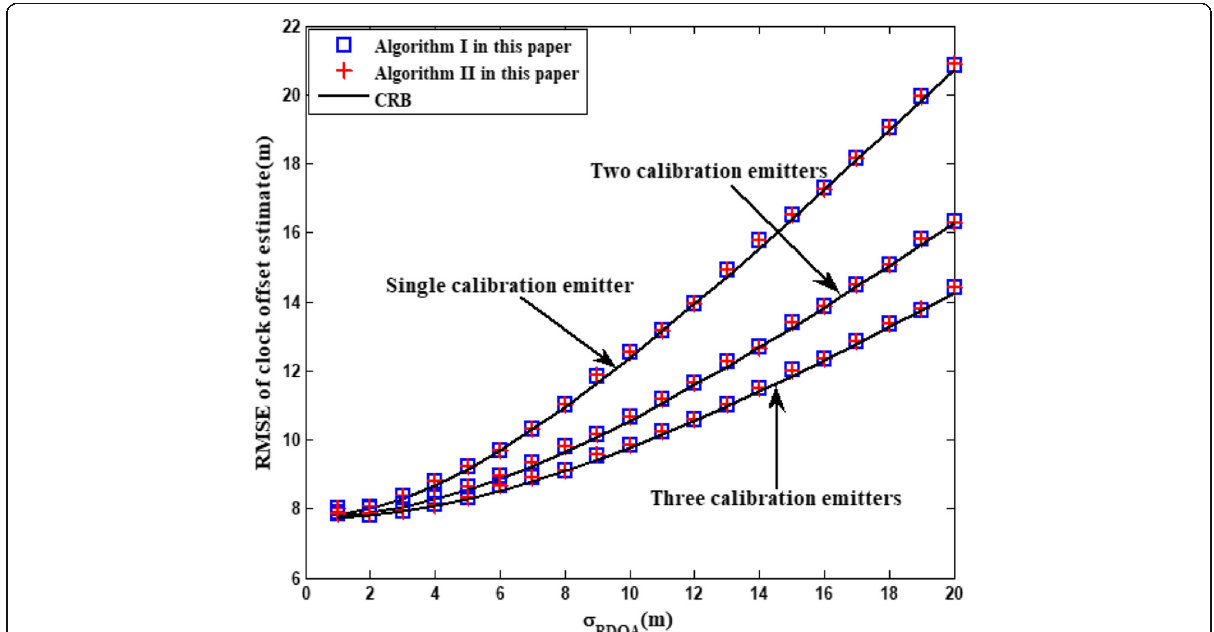
Fig. 17 RMSE of clock offset estimate versus σ RDOA for a different number of calibration